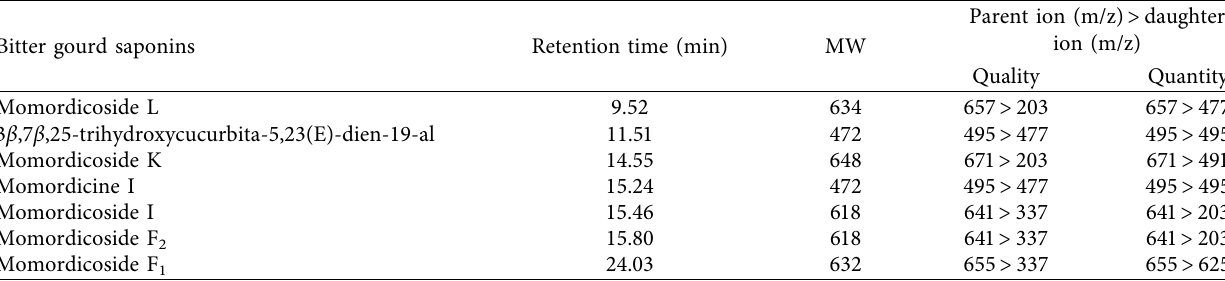
Figure 1: Structures of specific bitter gourd saponins. (a) Momordicoside L, (b) 3 β ,7 β ,25-trihydroxycucurbita-5,23(E)-dien-19-al, (c) momordicoside K, (d) momordicine I, (e) momordicoside I, (f) momordicoside F 2 , and (g) momordicoside F 1 . Glc denotes a glucose molecule. All denotes allose. Structures were drawn by MDL ISIS/Draw 2.5. Table 1: Retention times and fragment ions of bitter gourd